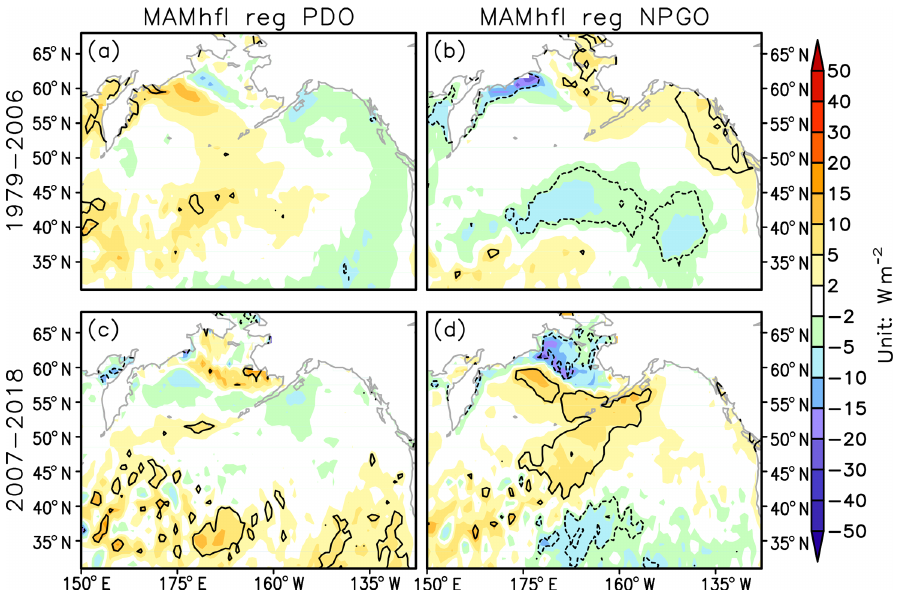
Figure 9. (a, b) Regression of March–May mean surface turbulent (sensible + latent) heat flux onto the PDO (a, c) and NPGO (b, d) indices during the period of 1979–2006. (c, d) Same as (a, b) , but for the period of 2007–2018. Solid (dashed) lines enclose the positive (negative) regression coefficients that are significant at the 95% confidence level.